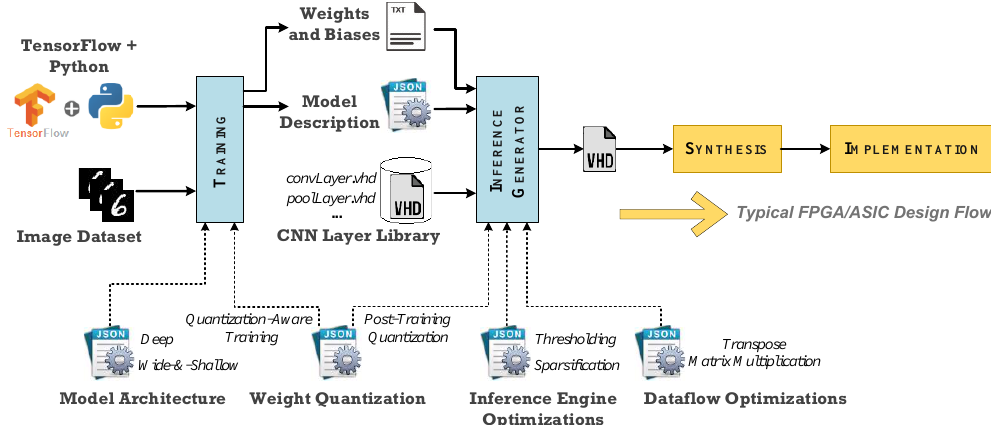
Figure 1. Proposed framework for generating high-throughput CNN hardware accelerators with TensorFlow. The user needs only to modify the JSON files to tune both the training and inference generation, and run the Python scripts ( Training , Inference Generator ) to produce a synthesizable